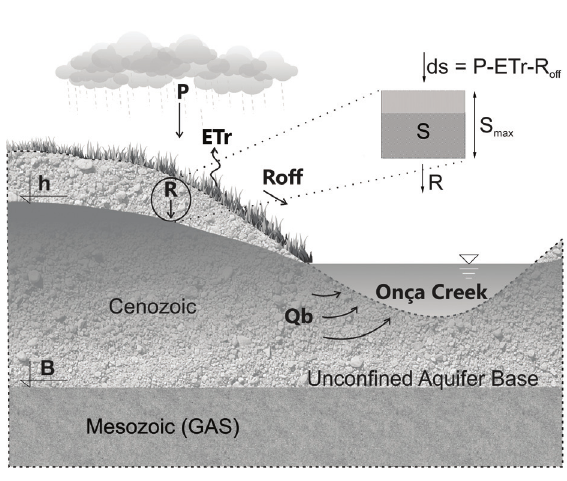
Figure 2 - Schematic drawing of a cross section in the OCB showing the unconfined aquifer modelled in SPA and water budget method used to estimate